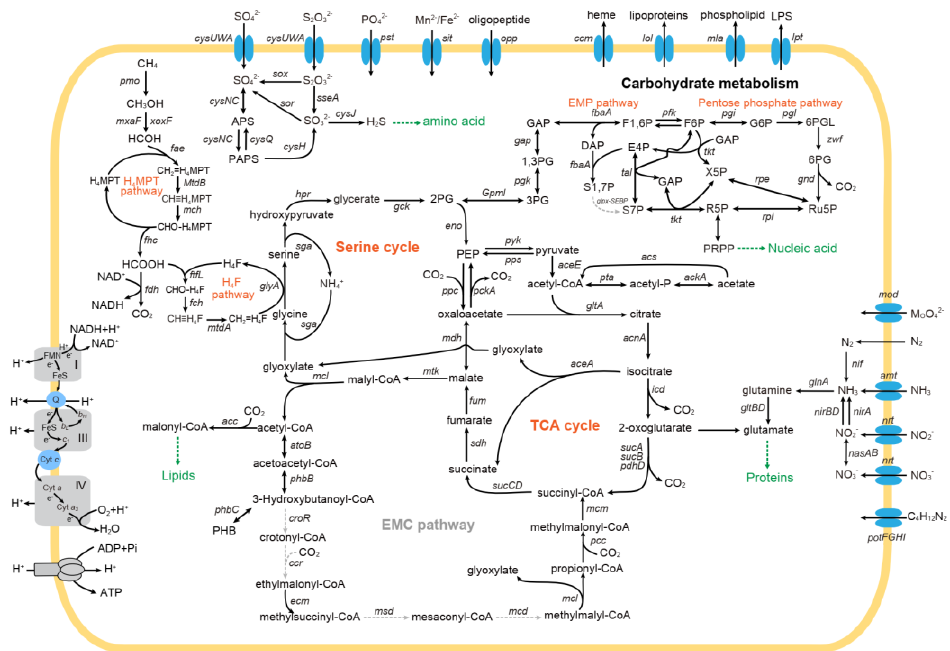
Figure 6. Metabolic reconstruction of MO3 based on the MAG MO3_YZ.1. Pathways are drawn on the basis of KEGG map files and KO assignments. Gray dashed arrows indicate the absence of these genes in this MAG. EMC, ethylmalonyl-CoA; EMP, Embden–Meyerhof–Parnas; LPS, lipopolysaccharide; PHB, poly- β -hydroxybutyrate; TCA, tricarboxylic acid.